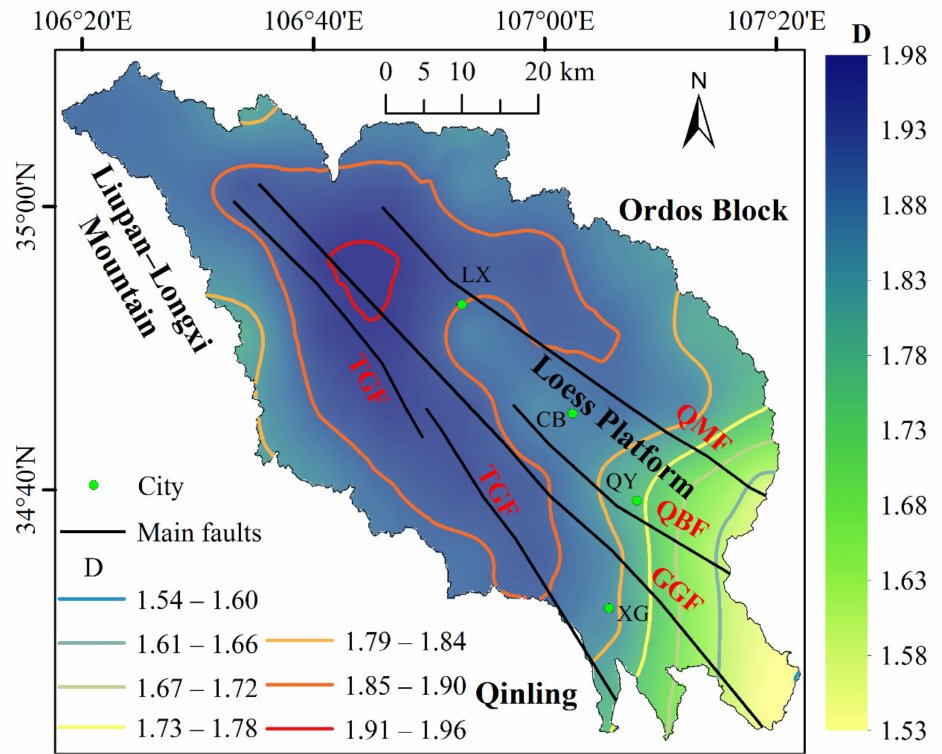
Figure 6. Fractal dimension isogram of lineaments in the Qianhe